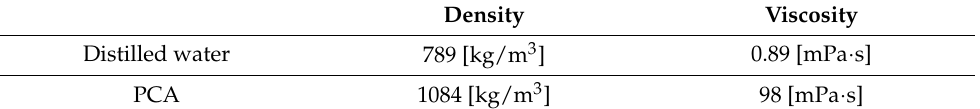
Table 3. Density and viscosity of solvent and dispersant.